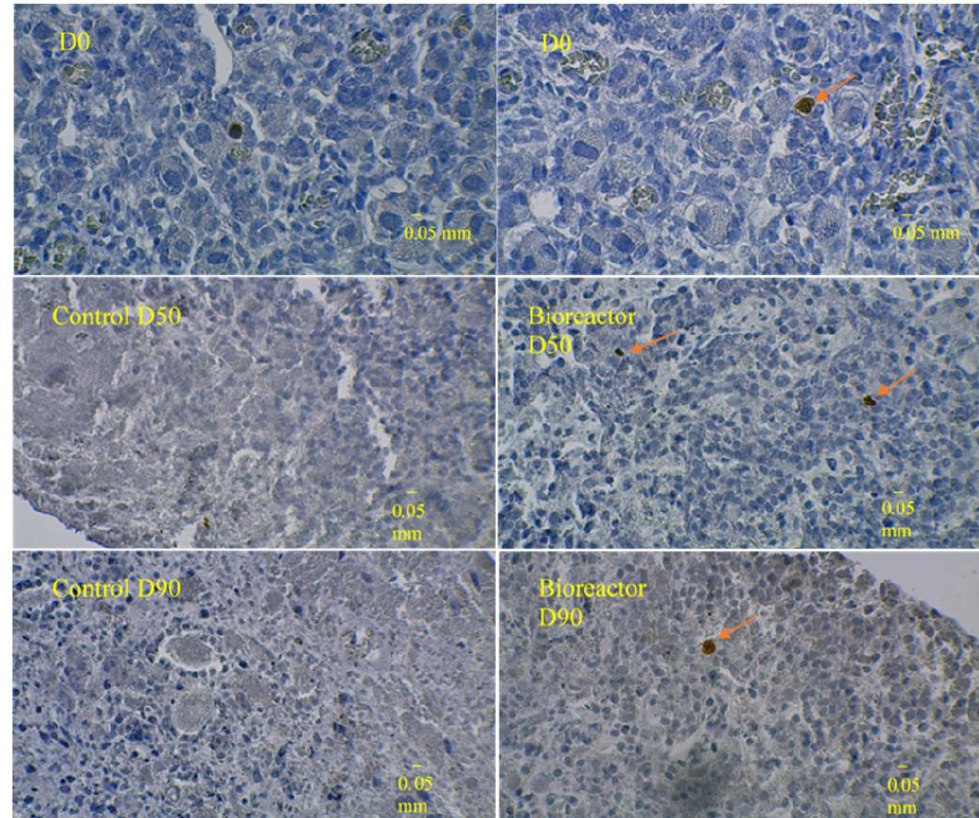
Figure 7. Cleaved caspase-3 immunostaining. Upper panel: Slice of fresh fetal ovarian tissue before culture. Middle row: Slices at day 50 of culture. Lower row: Slices at day 90 of culture. Left panels: control cultures. Right panels: bioreactor cultures. Apoptic cells — indicated by orange arrows — have brown cytoplasm.